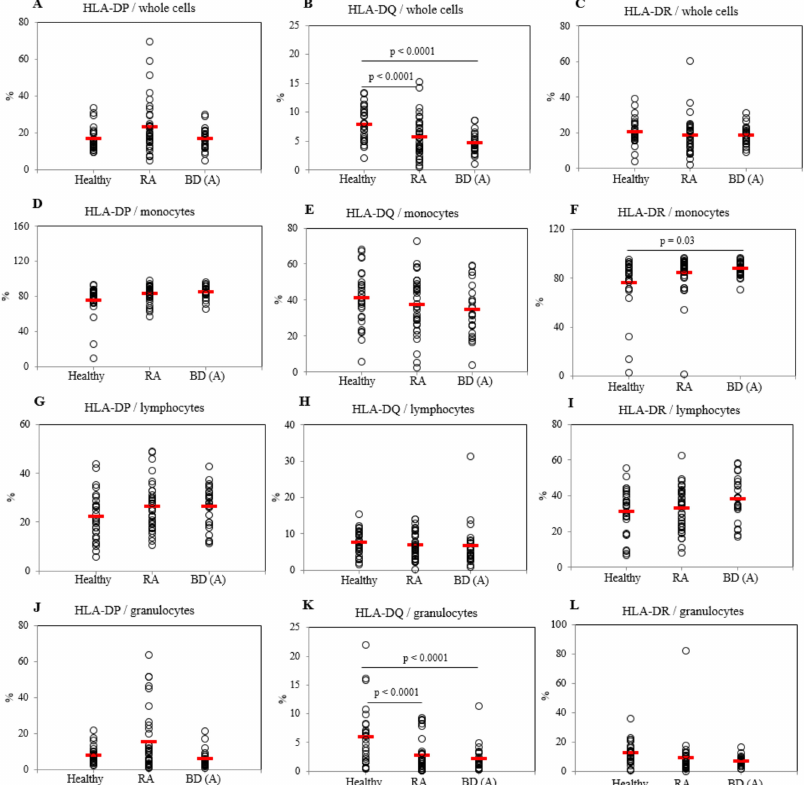
Figure 1. Frequencies of HLA-DP ( A ), DQ ( B ), and DR ( C ) in whole cells, monocyte ( D – F ), lymphocytes ( G – I ), and granulocytes ( J – L ) of healthy controls (HC), rheumatoid arthritis (RA), and active Behçet’s disease (BDA) patients. Isolated peripheral blood leukocytes (PBL) were subjected to flow cytometric surface staining. Results were obtained from 28 HC, 36 patients with RA, and 25 patients with BDA. The horizontal line specifies the mean value for each